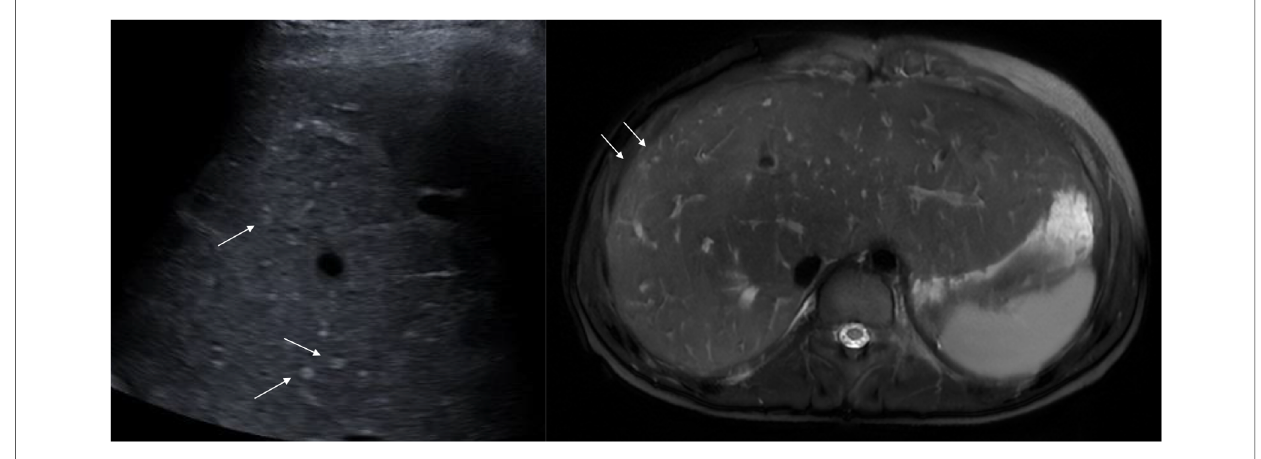
FIGURE 11 Typical hyperechogenic vascular nodules 3 – 5 mm (arrows) on ultrasound (left) and corresponding nodules with high signal on axial T2-weighted MRI (right). Note the generally increased T2 signal in the parenchyma as an expression of congestion (right). MRI, magnetic resonance